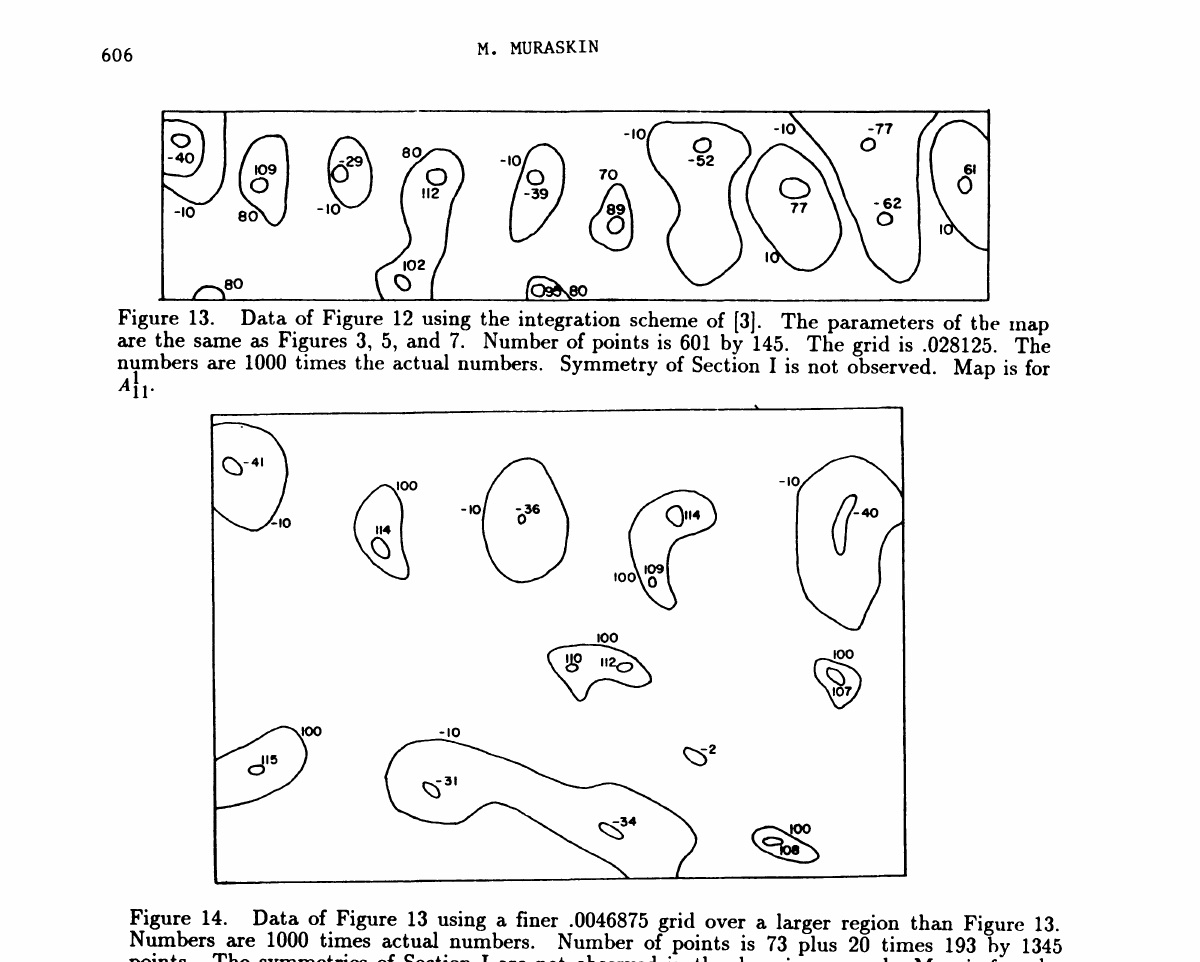
Figure 14. Data of Figure 13 using a finer .0046875 grid over a larger region than Figure 13. Numbers are 1000 times actual numbers. Number of points is 73 plus 20 times 193 by 1345 points. The symmetries of Section